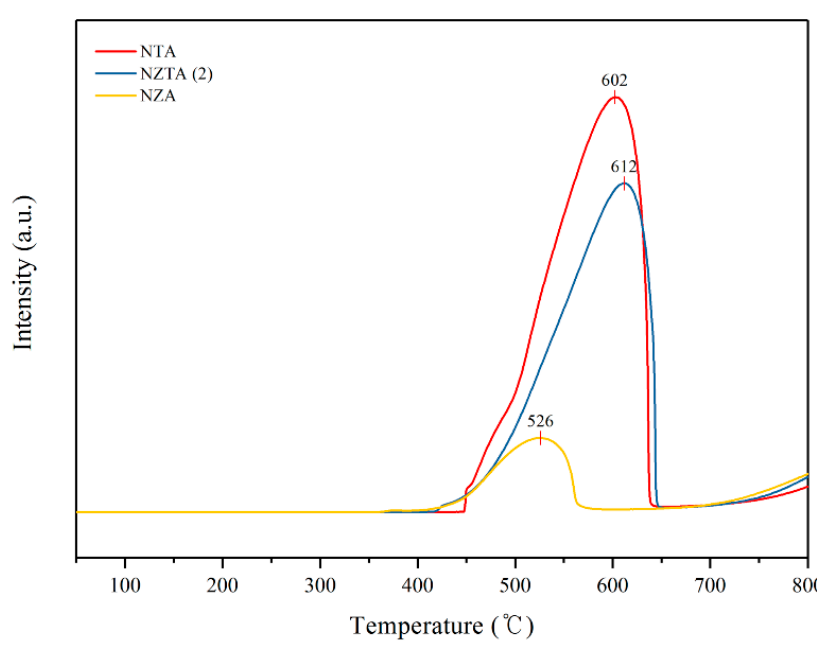
Figure 4. Temperature-programmed decomposition of methane over the reduced NZA, NZTA (2), and NTA catalysts. Reaction conditions: Total flow: 30 cm 3 / min; feed composition: CH 4 = 1.